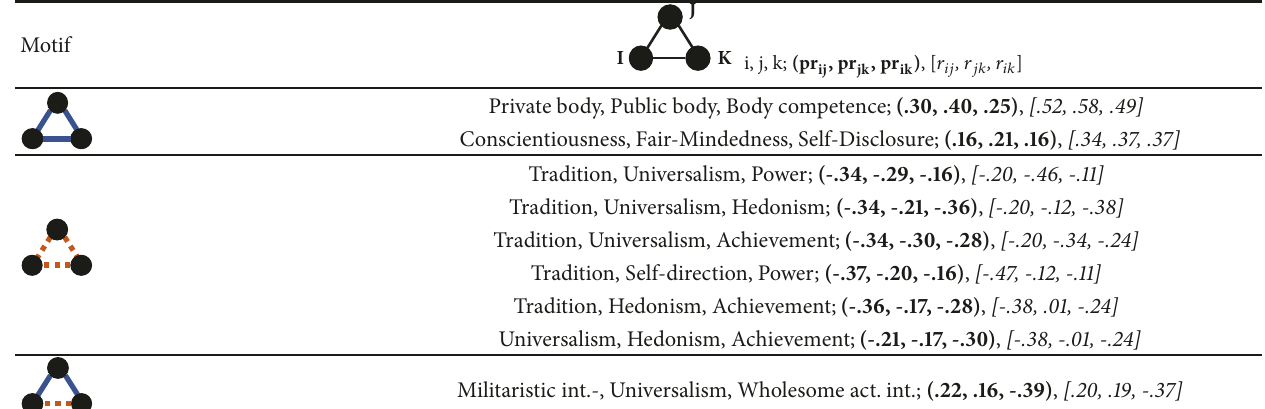
Table 3: Weighted and signed motifs